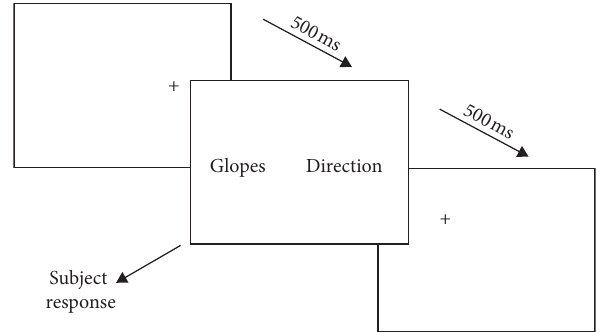
Figure 1: Images of the first three slides in the dot-probe